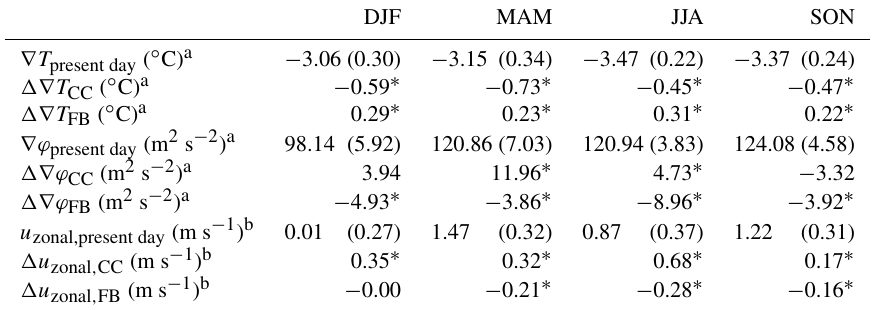
Table A2. Atmospheric temperature contrast, geopotential contrast and westerly wind speed for the present-day state and contributions from climate change (CC subscript) and vegetation feedbacks (FB subscript). Standard deviation is in parentheses.